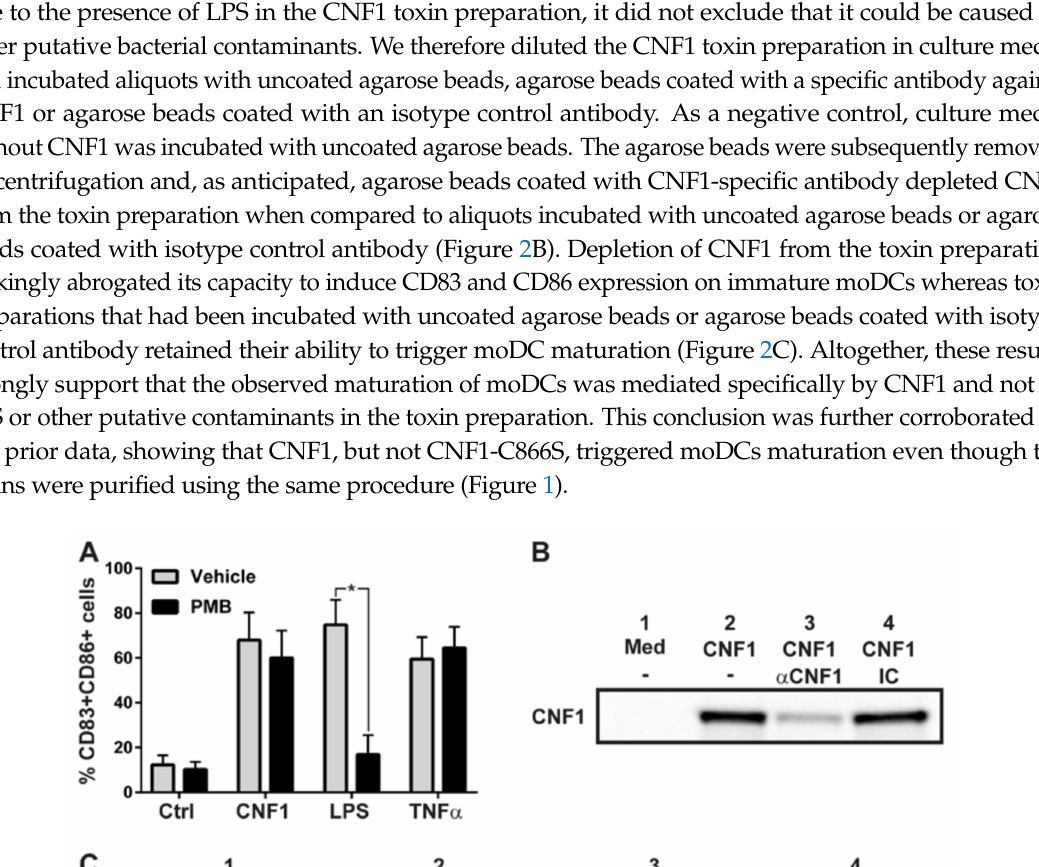
PMB-treated cells using a paired Student’s t -test. ( B ) CNF1 diluted in moDC medium was incubated with (2) uncoated Protein A agarose beads or (3) Protein A agarose beads that had been pre-coated with a monoclonal anti-CNF1 ( α CNF1) antibody or (4) an isotype control (IC) antibody. As a negative